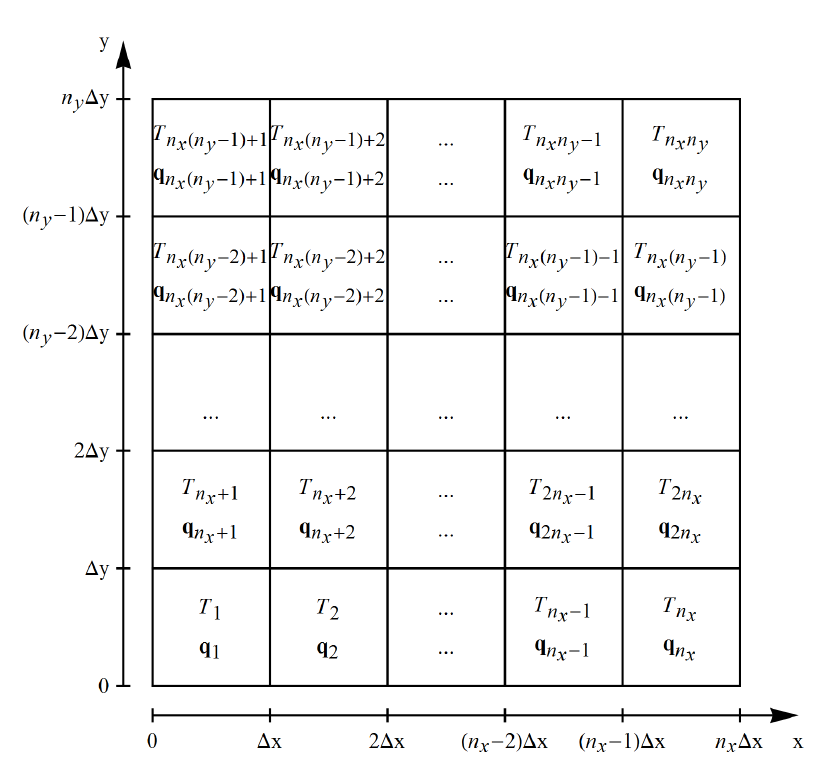
Figure 1. Geometry of cross-sectional area of the investigated test structure.